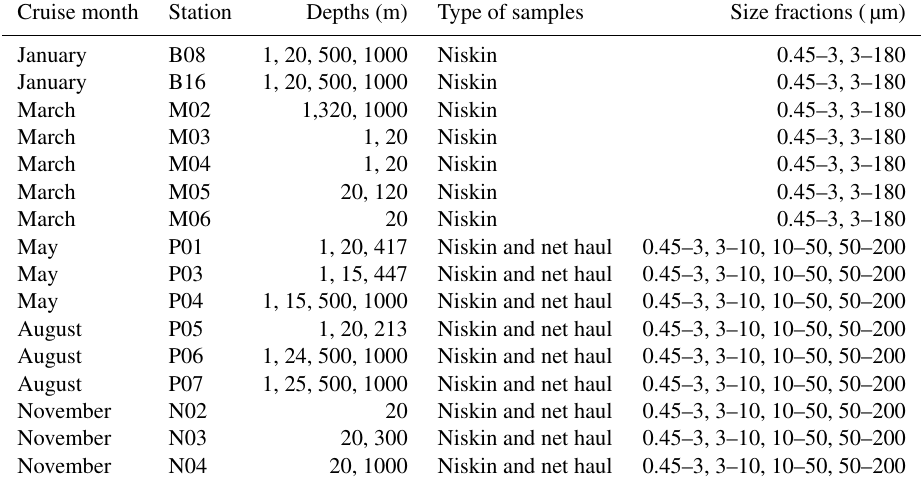
Table 2. Overview of which stations, depths, type of samples, and size fractions were sampled in each of the cruise